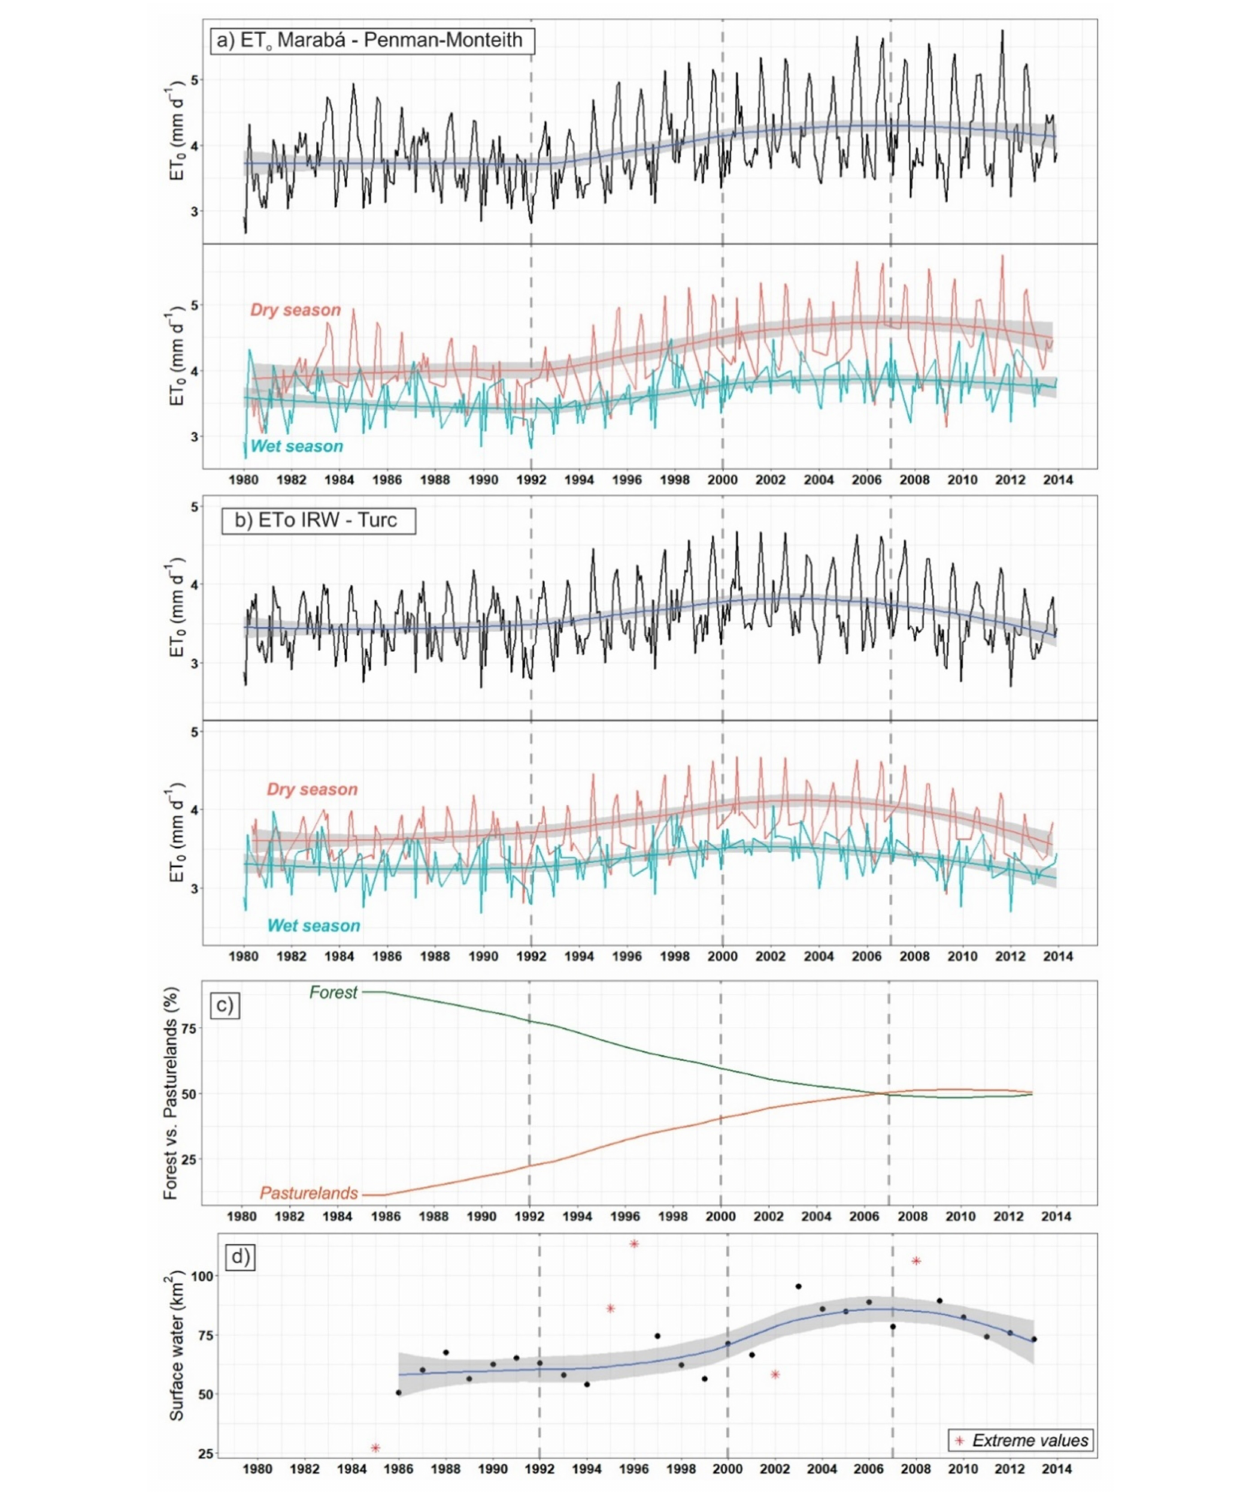
FIGURE 3 | Annual and seasonal variability in ET o by the (a) Penman-Monteith method for Marabá station and (b) the Turc method for the IRW (1980–2013). In (c,d) , the evolution of forest conversion into pasture and the sum of the surface area of water bodies in each year from 1985 to 2013 are shown, respectively. Source: ET o data from Silva Júnior et al. (2017a) and land use and cover and water body data from the (Project MapBiomas Alerta, 2017) (https://mapbiomas.org/).